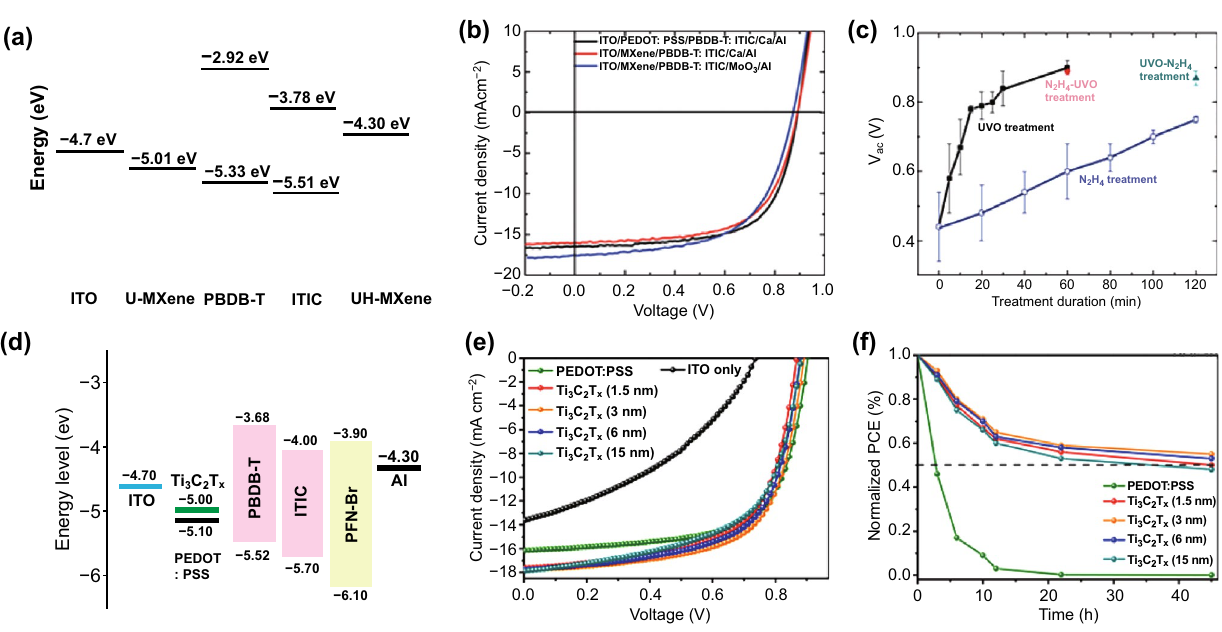
Fig. 9 PBDB-T:ITIC-based OSCs using the UV–O 3 and/or N 2 H 4 -treated Ti 3 C 2 T x MXene as the ETL/HTL: a Energy levels of the main com- ponents and b illuminated J – V curves of the PBDB-T:ITIC-based OSCs. Here, U-MXene and UH-MXene denote the MXene treated only by UV–O 3 , and first by UV–O 3 and then by N 2 H 4 , respectively. Moreover, U-MXene is used for the hole collection in the normal OSCs, and the UH-MXene is for the electron collection in the inverted OSCs; and c V oc versus the treatment duration. Copyright © 2019 The Royal Society of Chemistry. PBDB-T:ITIC-based OSCs using Ti 3 C 2 T x nanosheets as the HTL: d Energy-level alignment of each component, e illuminated J – V curves, and f stability test under the atmosphere condition without any encapsulations. Copyright © 2019 The Royal Society of Chemistry